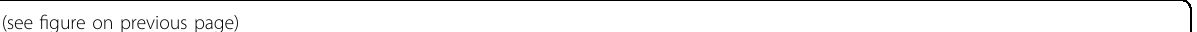
Fig. 4 Sc-RNA Seq reveals that the overexpression of human SERPINA3 increases upper-layer neurons. a Pipeline of sc-RNA Seq processes with P0 WT and cKI f/ + cortex. b t-SNE plot for integrated WT and cKI f/ + transcriptome, red represents WT cells and blue represents cKI f/ + cells. c t-SNE plot for integrated WT and cKI f/ + transcriptome, each color shows a cell type cluster. Detail information of 11 cell types is on the right side. d Bar plot shows the ratio of each cell types. e t-SNE plot for different neuronal cell types. f Bar plot shows the ratio of each neuronal cell